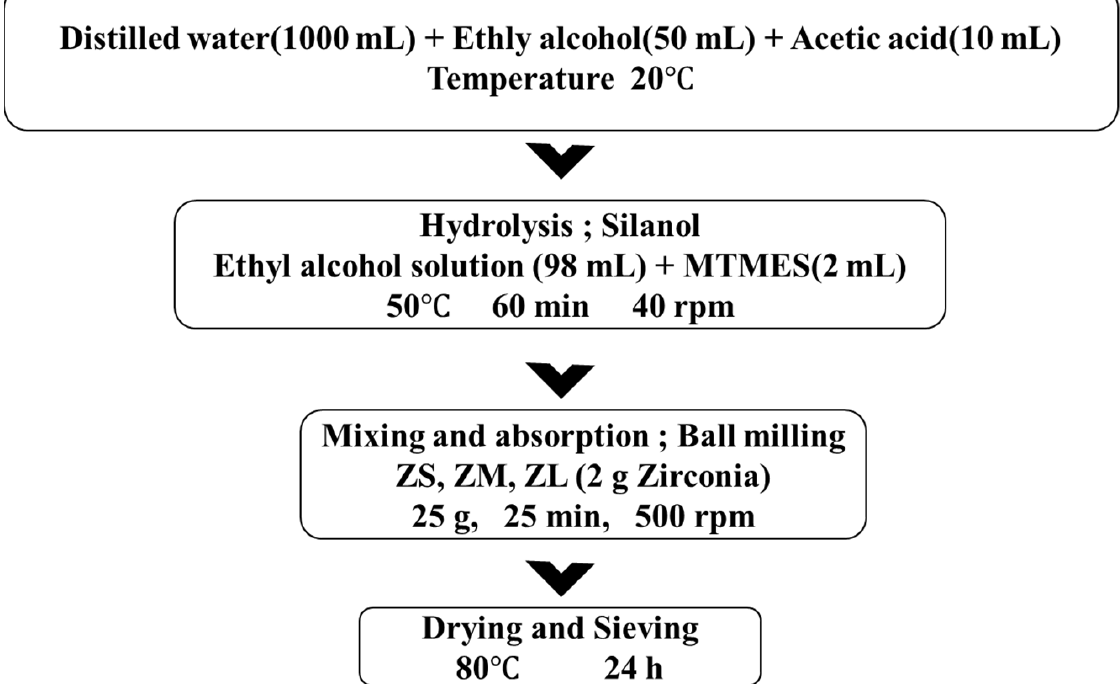
Figure 2. Flowchart of powder modification and suspension.